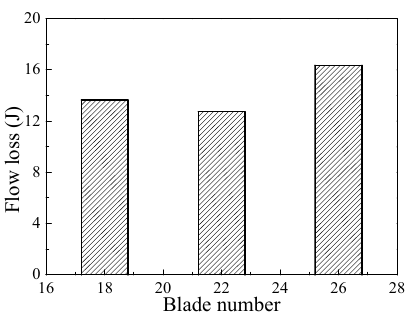
Figure 8. Static pressure distribution along the nozzle blade surface with installation angle 32°.